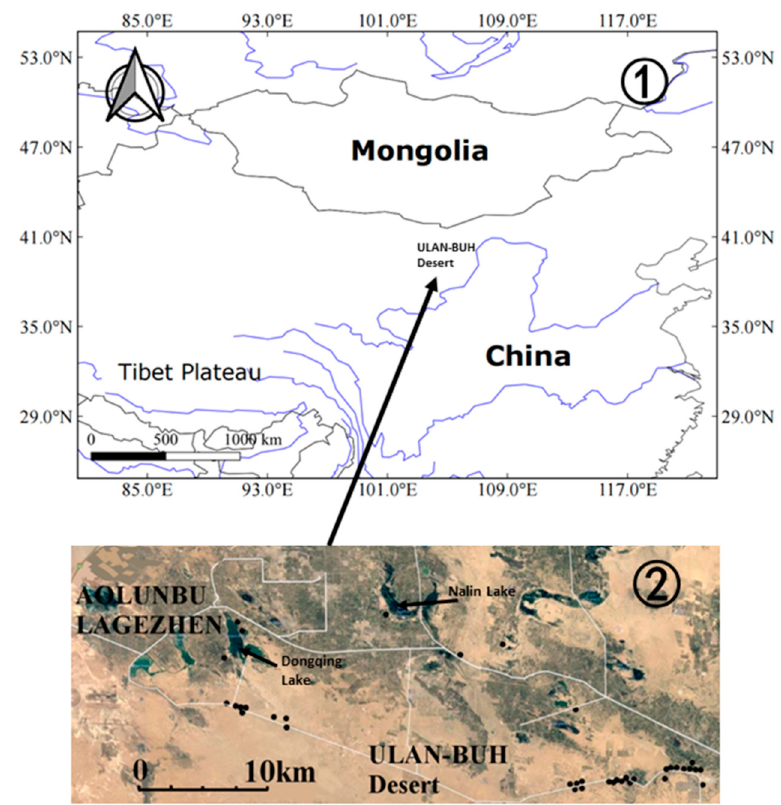
Figure 1. Map of study area of this study: (1) The geographical location of Ulanbu desert; (2) The location of each sampling site (represented by back spots) in the desert. Two permanent lakes are indicated with arrows.